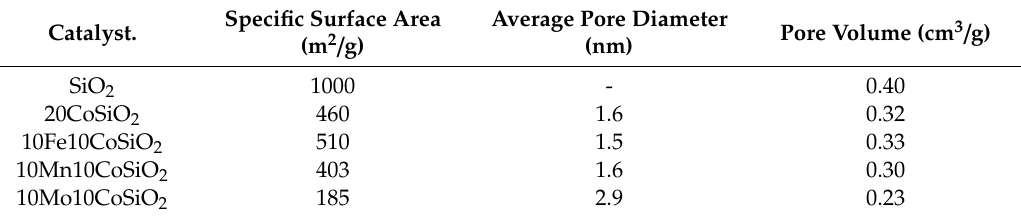
Table 1. Surface area and pore size of